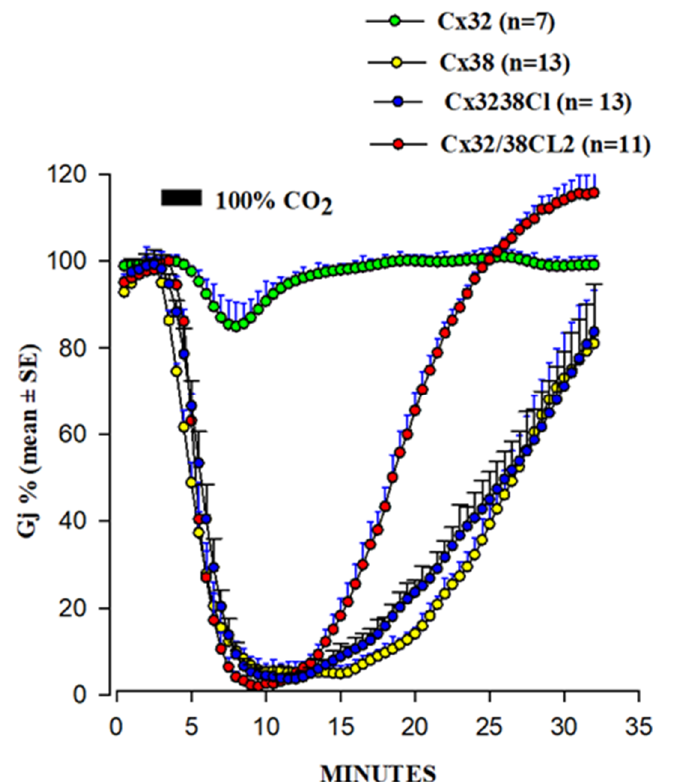
Figure 7. Gj drop induced by 100% CO 2 in oocyte pairs expressing Cx32, Cx38, or Cx32/38 chimeras. Channels made of Cx32/38CL (Cx32’s CL replaced with that of Cx38) or Cx32/38CL2 (Cx32’s CL2 replaced with that of Cx38) reproduce the gating efficiency of Cx38 channels, although Gj recovers faster in Cx32/38CL2 channels. Adapted from refs. [108,109].